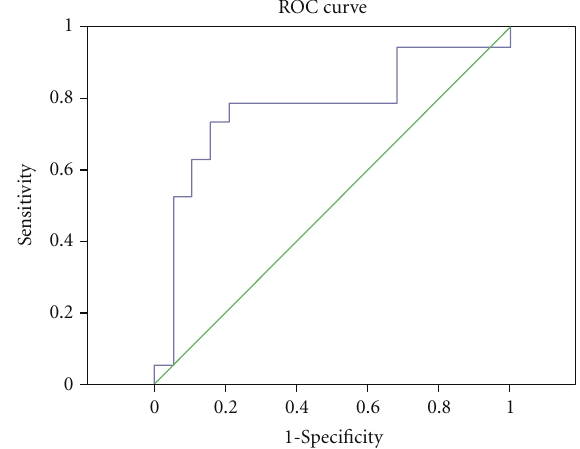
Figure 1: ROC curve for iPTH (AUROC = 0 . 776 ± 0 . 067; 95% CI: 0.645–0.906; P = 0 .